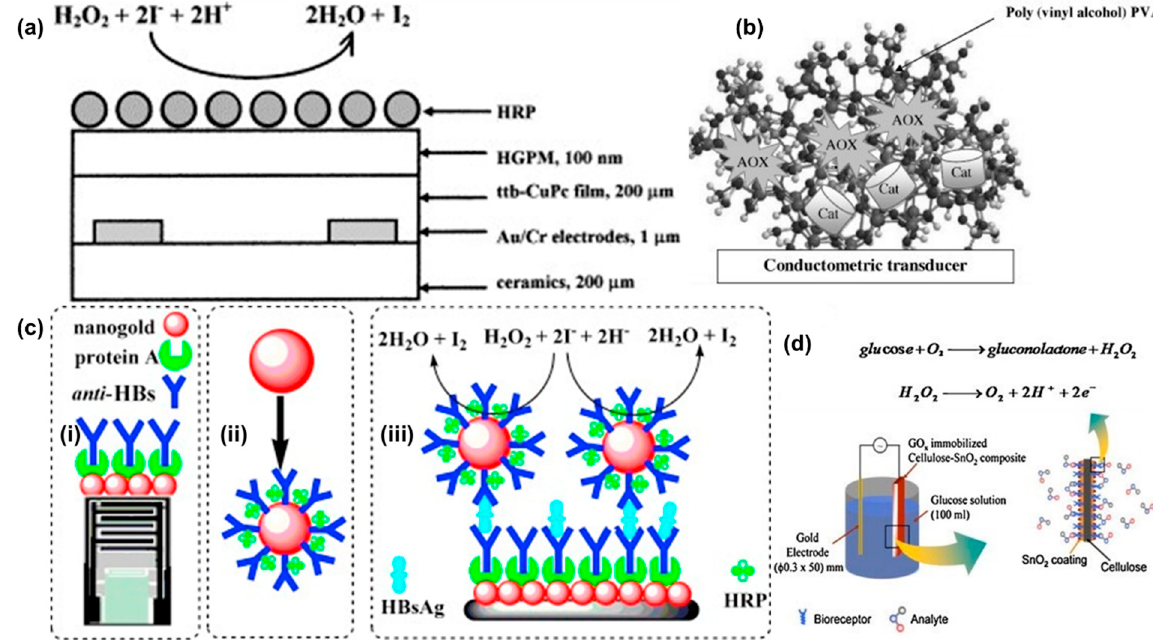
Figure 6. ( a ) A HRP conductometric sensor for enzymatic detection of H 2 O 2 . The sensor was fabricated using HRP as the enzyme and ttb-CUPc as the active/sensitive film to detect the released iodine molecule. Reprinted from [38] with permission from Elsevier. ( b ) A bi-enzyme sensor (Alcohol oxidase and catalase) to detect alcohol using conductometric transducer. Reprinted from [39] with permission from Elsevier. ( c ) (i) Schematics of a conductometric transducer working as an immunosensor (ii) A nanogold particle coated with anti-HBs and protein A (iii) Schematics of the sandwich immunoassay with the reactions involved to measure Hepatitis-B surface antigens. Reprinted from [42] with permission from Elsevier. ( d ) Schematics of a GOD immobilized cellulose-SnO 2 composite electrode. Reprinted from [46] with permission from Elsevier.